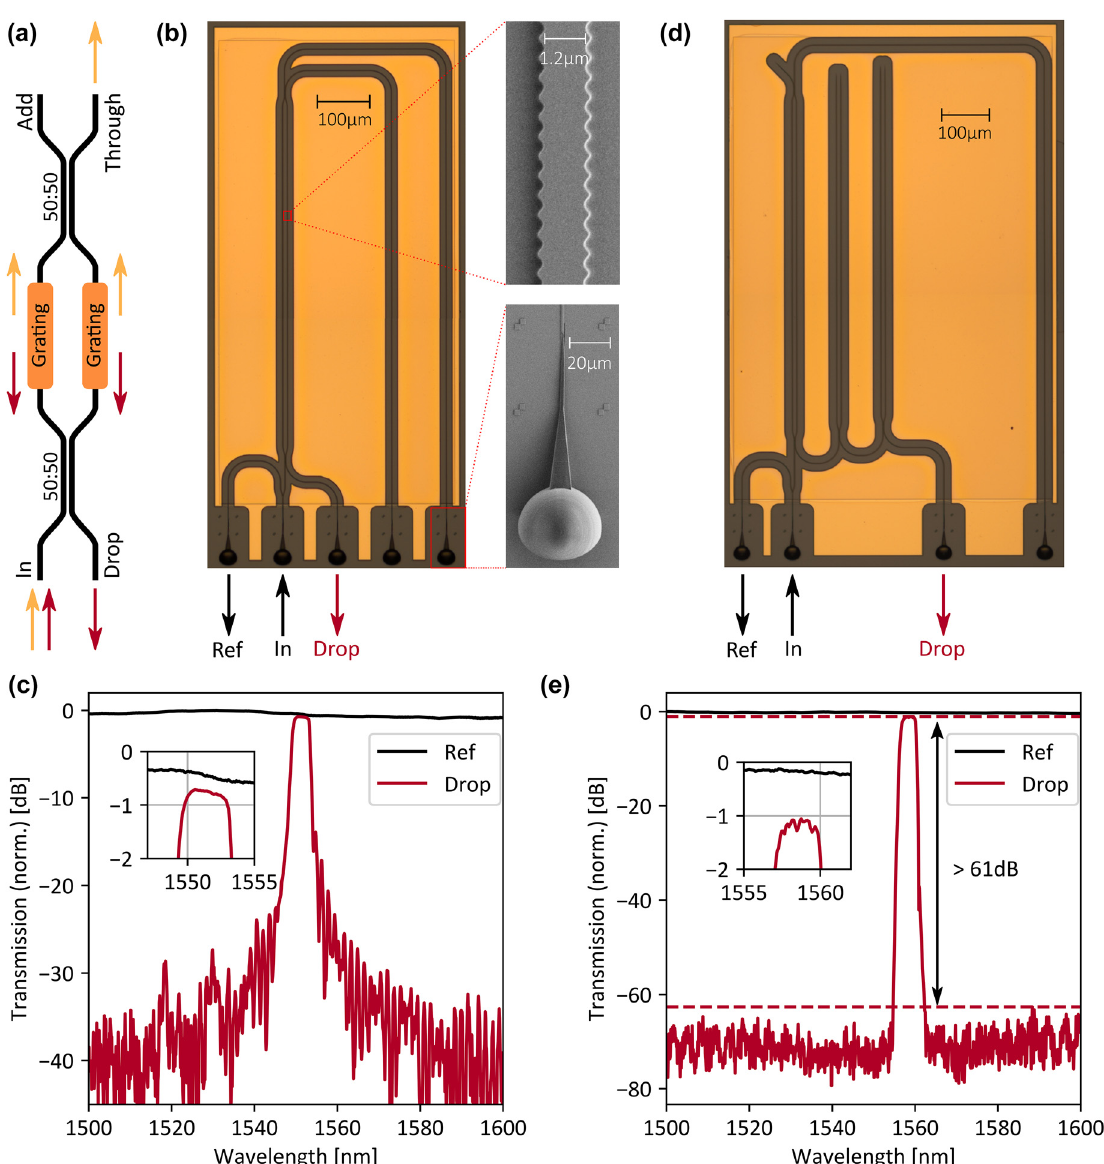
Figure 2: Bragg scattering add-drop filter. (a) Working principle of a Bragg add – drop filter. The input is equally split into a Mach – Zehnder interferometer like structure with identical Bragg filters placed in both arms. The reflected light interferes constructively at the Drop port and the transmitted light at the Through port. (b) Photonic circuit to characterize a single add – drop filter. We couple a laser to the In port and measure the transmission to the Reference (Ref) and Drop port. The close-up SEM images show the shape of the Bragg grating and the three- dimensionaltotalinternal reflectioncoupler deployed forfiber to chip coupling.(c)Singlefilter transmission. Dueto thegrating design,there is only one main reflection peak and the insertion loss is below 0.25 dB. (d) Photonic circuit to characterize a cascaded add – drop fi lter. (e)Cascaded fi ltertransmission.Thetransmissionshowsanoiselikebehavioroutsidethedesignedre fl ectionpeaklikelycausedbyscattered light. The extinction ratio becomes larger than 61